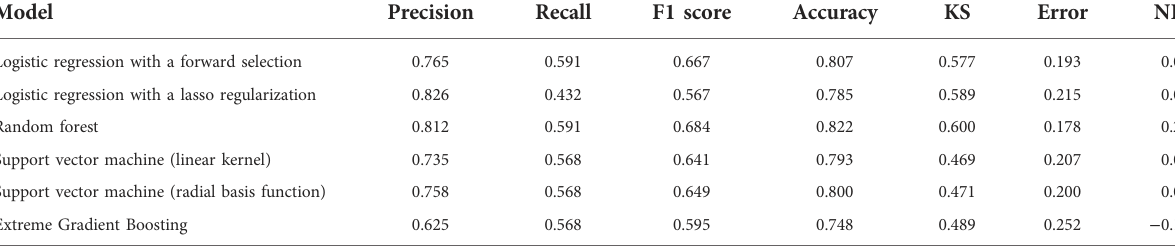
TABLE 3 Evaluation results of models for AKI risk of patients after cardiac surgery.